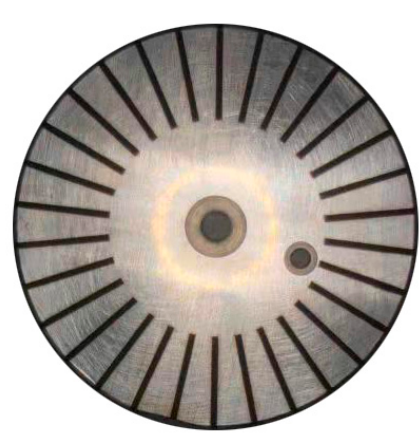
Figure 1. Nanosecond texture.